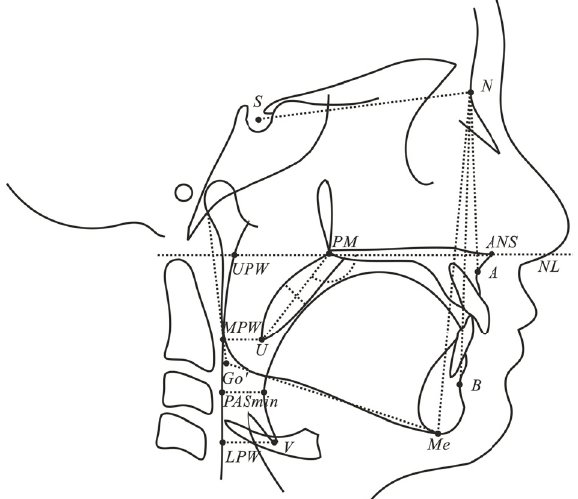
Figure 2: Cephalometric landmarks and measurements.